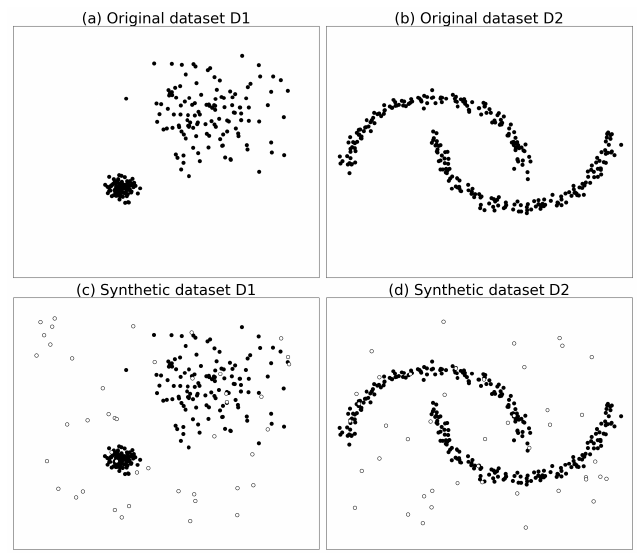
Figure 3. Synthetic datasets in Table 2, the upper frames represent the original clusters ( black ) in the datasets D1 and D2, and the lower frames represent the synthetic datasets with outliers ( white ) generated by a Gaussian